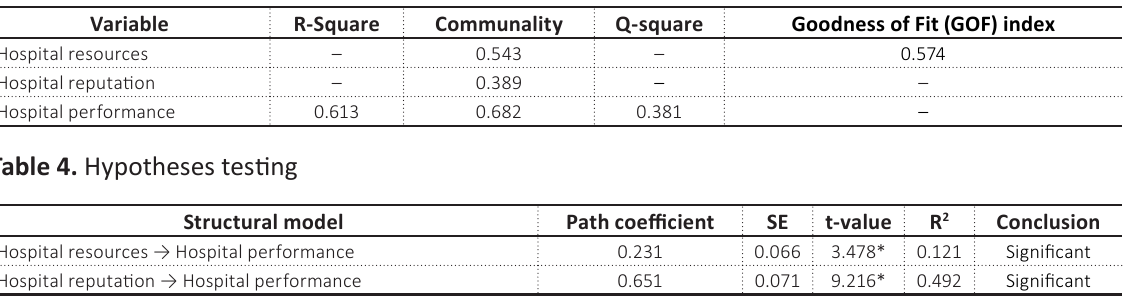
Table 3. Evaluation of R-Square value and GOF